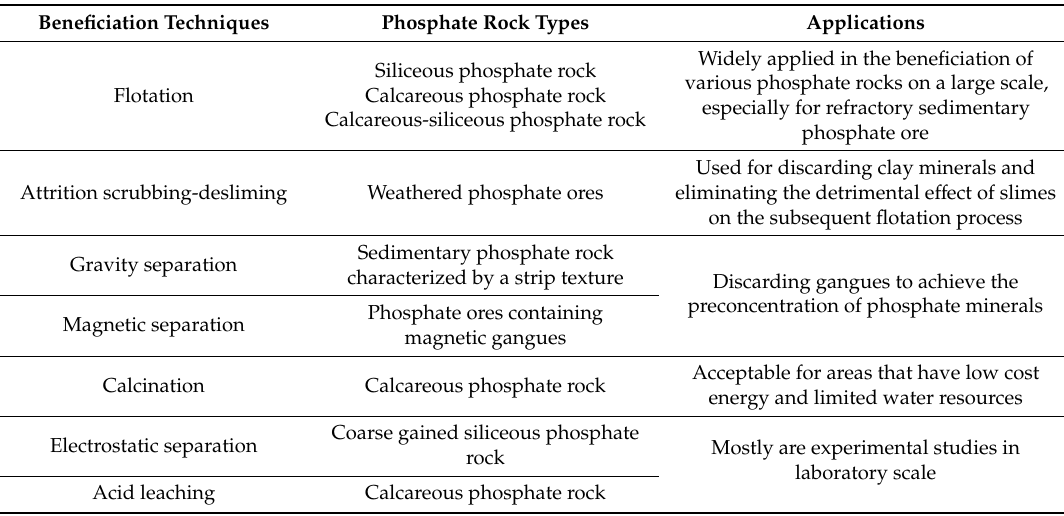
Table 1. Beneficiation techniques and their applications for various phosphate